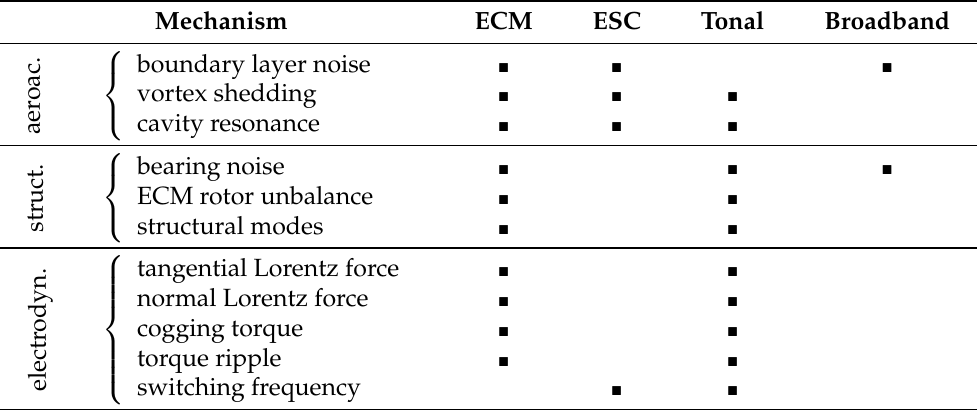
Table 2. Acoustic sources and characteristics in axial fans associated with the electric powertrain [5]. The marker (cid:4) describes the occurrence of a mechanism.